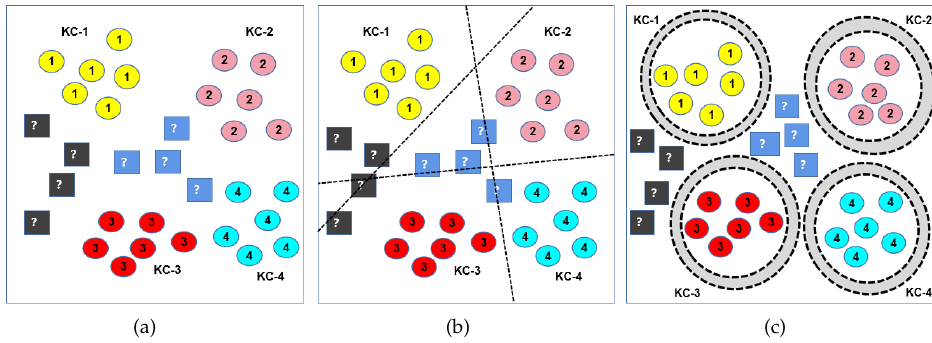
Figure 1. The comparison of CSA classification and OSA classification: ( a ) Distribution of the original dataset; ( b ) Based on CSA classification method; and ( c ) Based on OSA classification